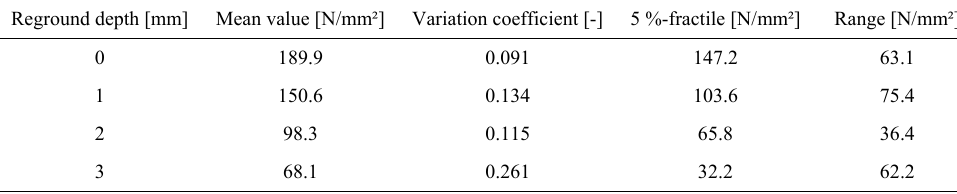
Table 4: Statistical evaluation FT specimens